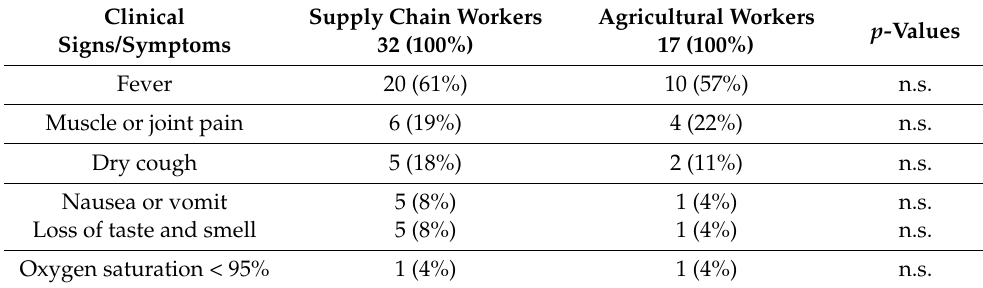
Table 3. Main clinic/symptoms signal occurred in 49